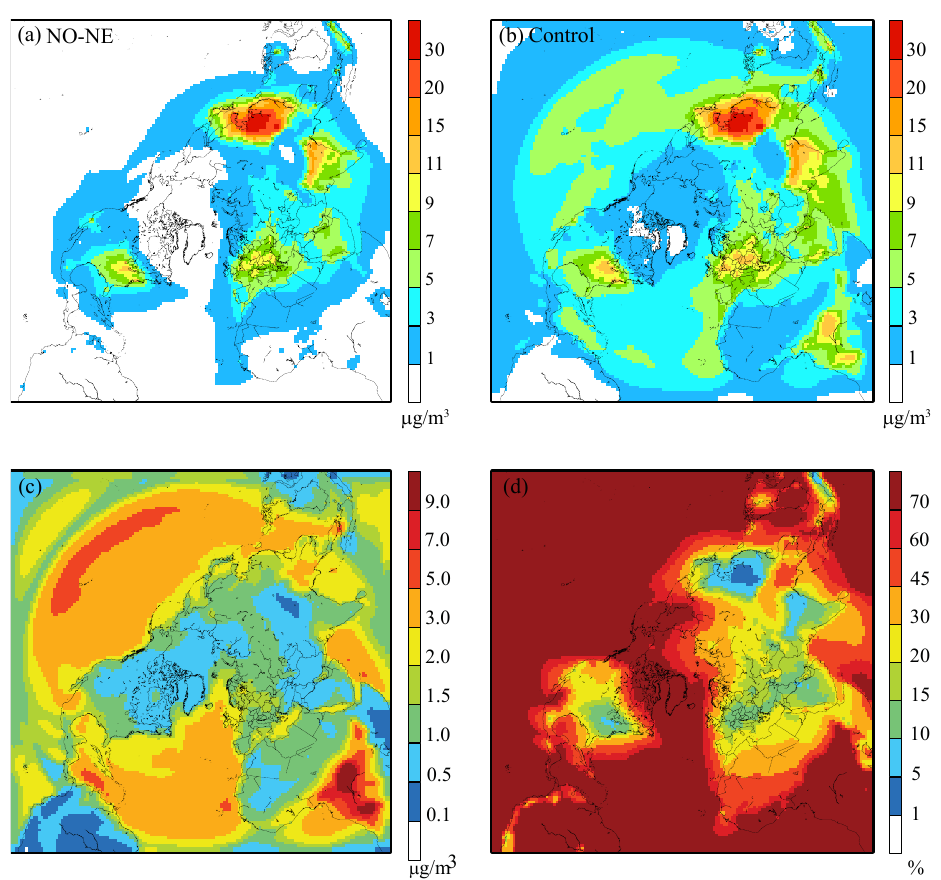
Fig. 13. The annual average PM 2 . 5 concentrations (µgm − 3 ) simulated by DEHM for (a) a sensitivity simulation by turning off all natural emissions (NO-NE), and (b) a control simulation including all emission sources, for 2006, together with (c) their absolute, (d) and relative